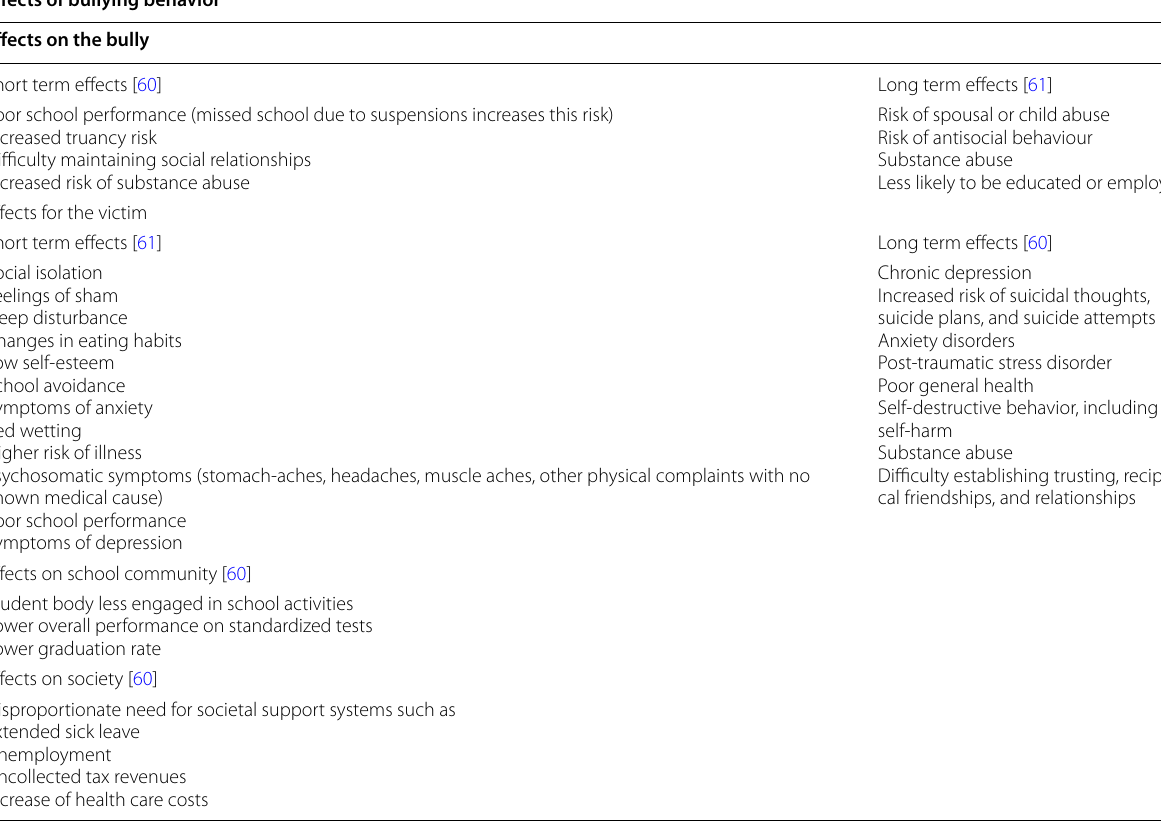
Table 2 Effects of bullying behavior